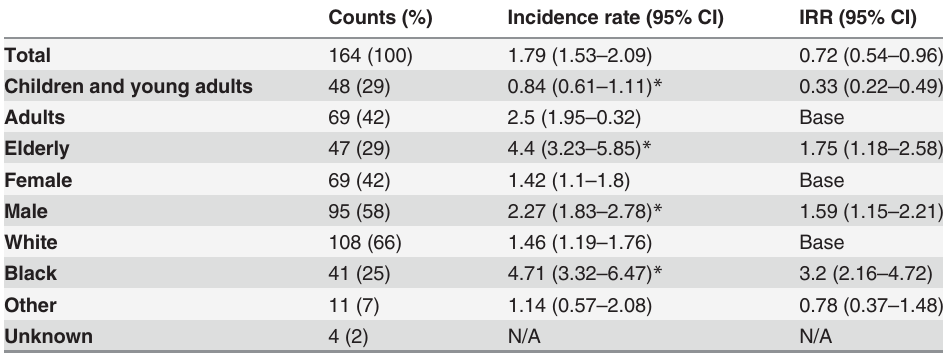
Table 2. Incidence rates and incidence rate ratios (IRR) per 10 million